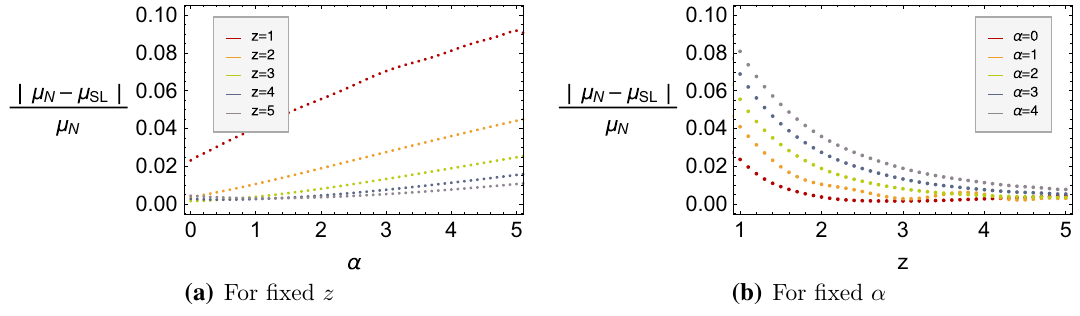
Fig. 2 A comparison of the values of μ in the Sturm–Liouville method and the numerical results method and we show the dashed and solid lines